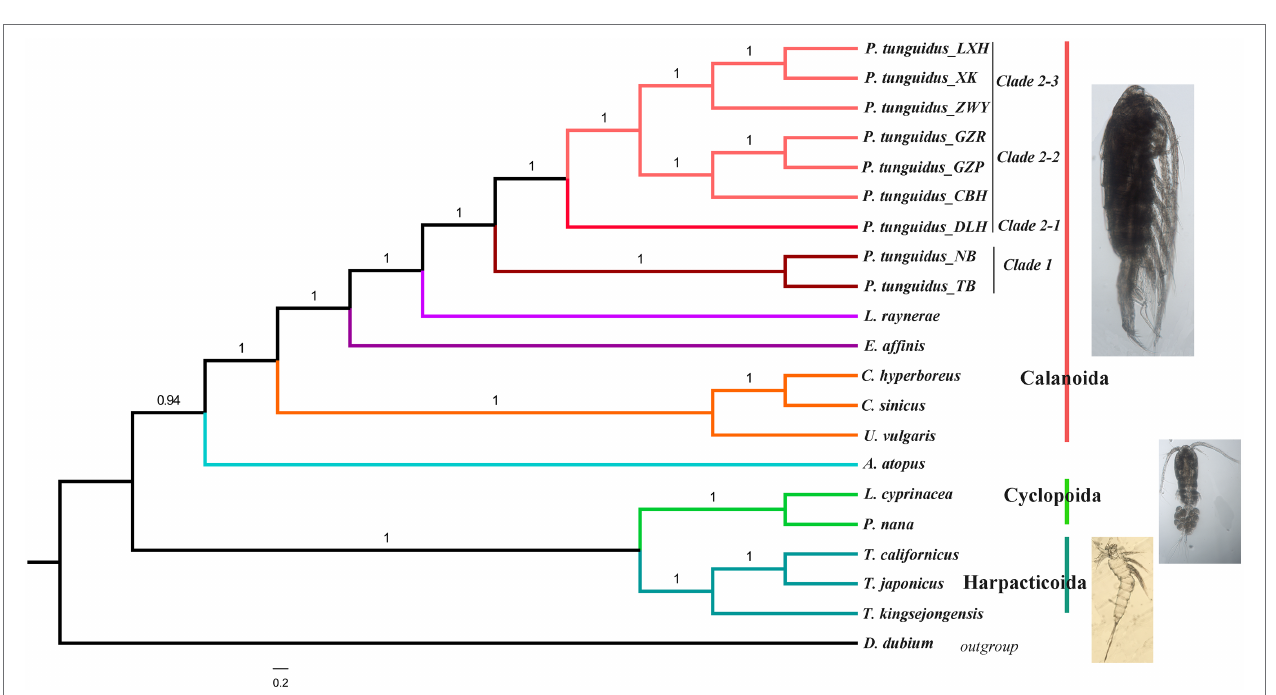
FIGURE 6 | The mitochondrial genome composition and arrangement of Copepoda. The protein-coding genes (PCGs) are colored according to functional group and tRNA genes are portrayed using their single-letter amino acid code.